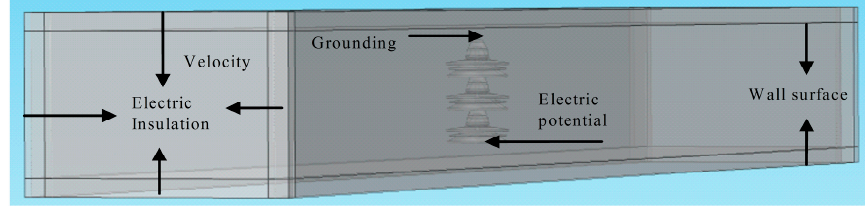
Figure 3. Schematic diagram of geometric physical model and boundary condition of low velocity section in the wind tunnel test.